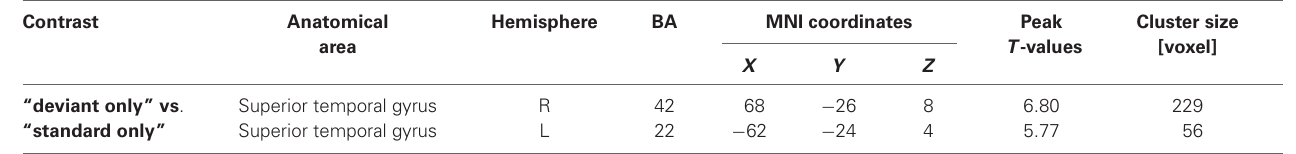
Table 1 | Deviance responses .